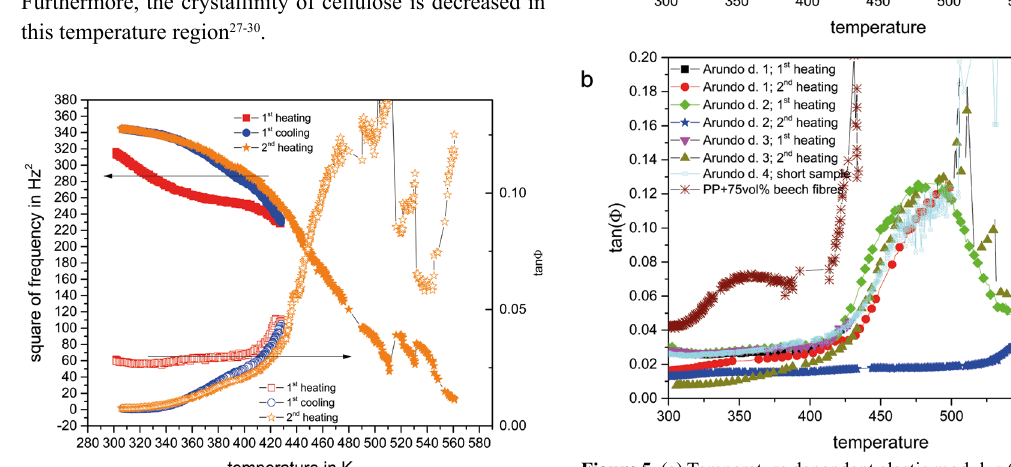
Figure 5. (a) Temperature dependent elastic modulus (αf 2 ) for two Arundo donax samples (Arundo d. 1 and Arundo d. 3) in a first heating cycle up to 430 K followed by a second heating cycle up to 575 K and for one Arundo donax sample (Arundo d. 2) heated